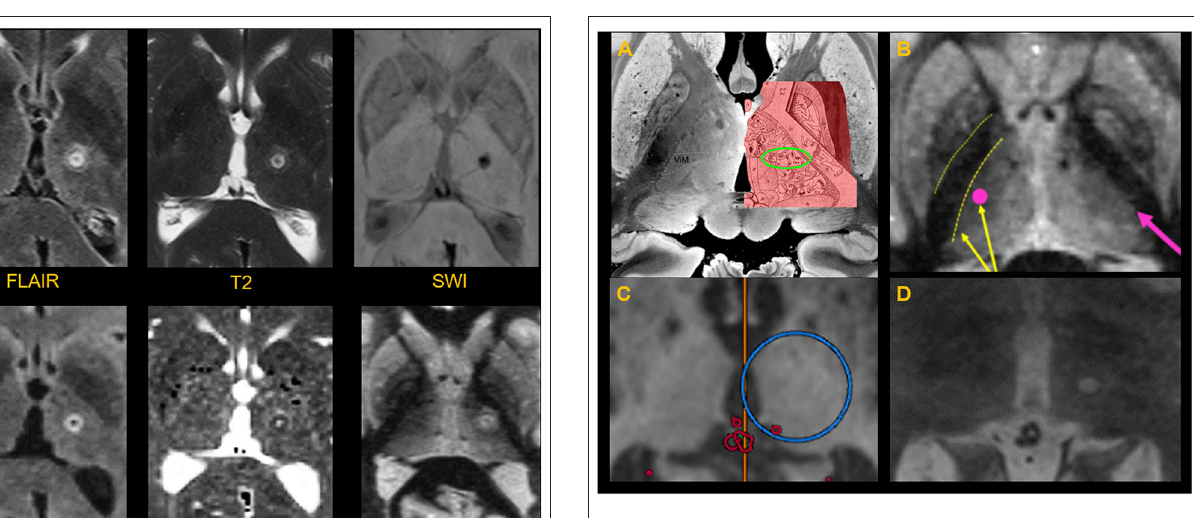
FIGURE 9 | (A) Thalamic homunculus superimposed over the thalamus in post mortem ultra–high-resolution images obtained at 7T. The green circle indicates the location of the ventral intermediate nucleus (Vim). (B) Fast gray matter acquisition T1 inversion recovery scan shows sharp demarcation between the IC (internal capsule) and thalamus, allowing adjustment of the target selection to avoid lesion spread into the IC. (C) Target coordinate selection during treatment planning using the anterior commissure–posterior commissure as standard references for localizing the target. (D) A successful lesion is created at the Vim, confirmed with a T2-weighted image obtained immediately after sonication with the ablative